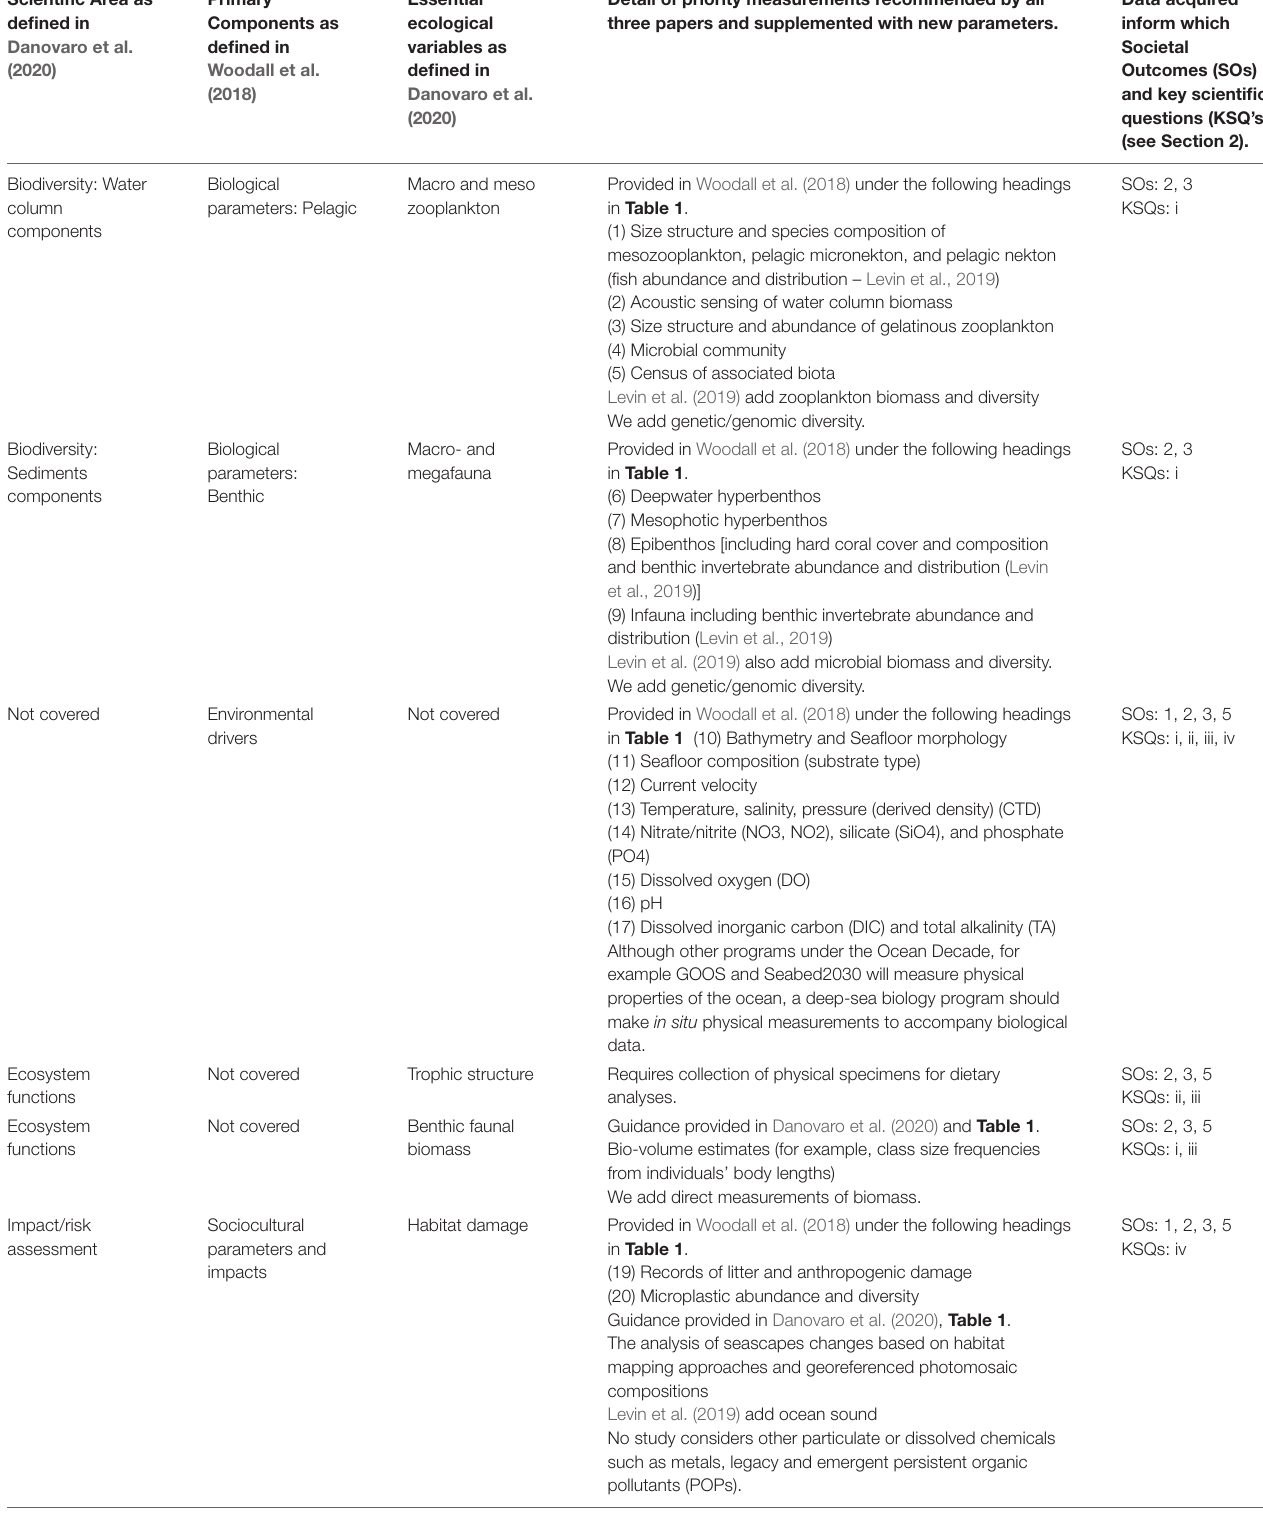
TABLE 2 | Woodall et al. (2018); Levin et al. (2019), and Danovaro et al. (2020) recommendations for what to measure and how, aligned for equivalency, and supplemented by additional considerations. Scientific Area as Primary defined in Components Danovaro et al. (2020)